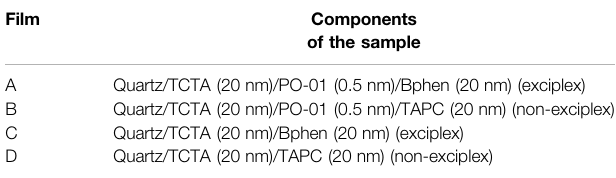
TABLE 1 | Components of samples A, B, C, and D. Film Components of the sample